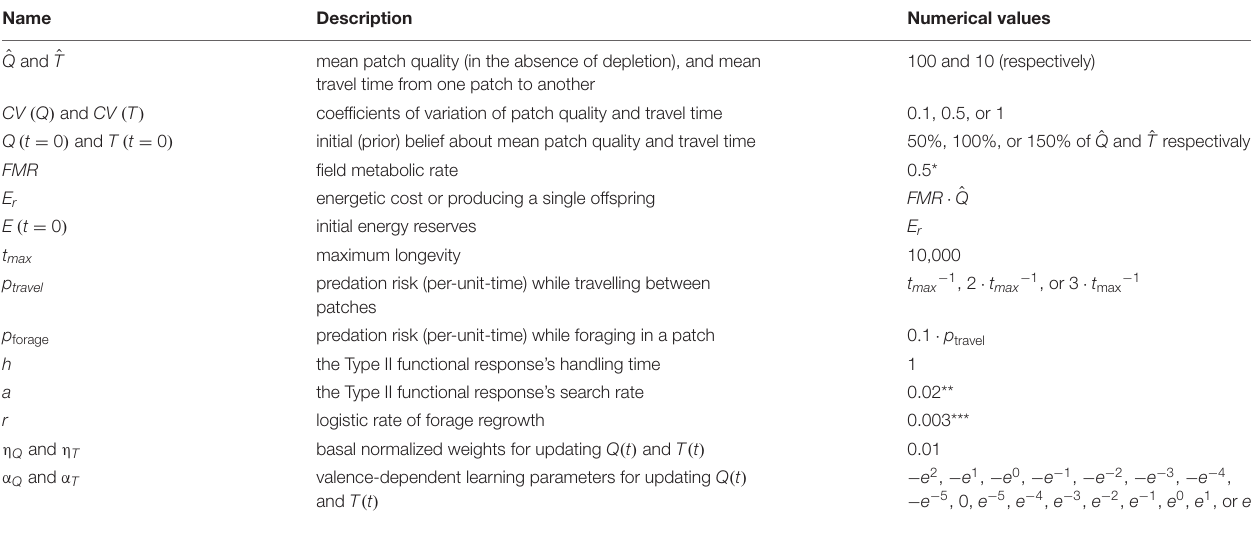
TABLE 1 | the various parameters and state variables used in our numerical